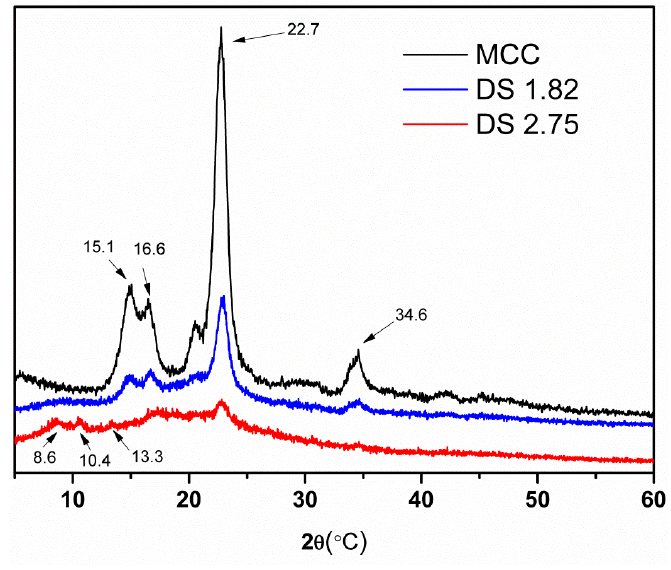
Figure 4. XRD patterns of MCC and CA samples with DS of 1.82 and 2.75.